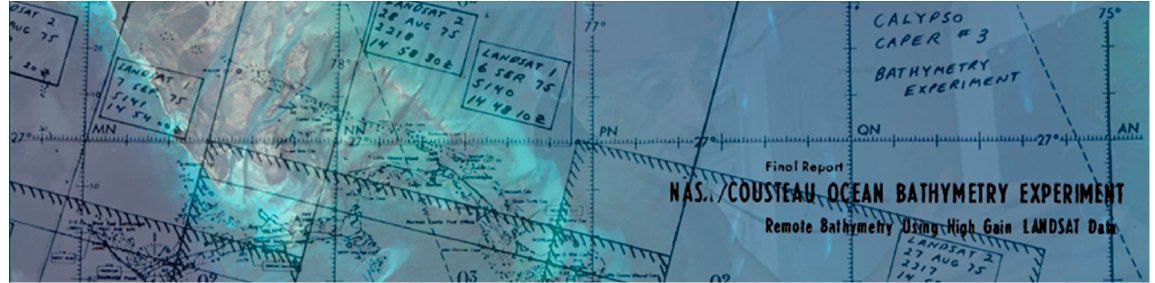
Figure 1. Cousteau chart made by the SDB method [4].